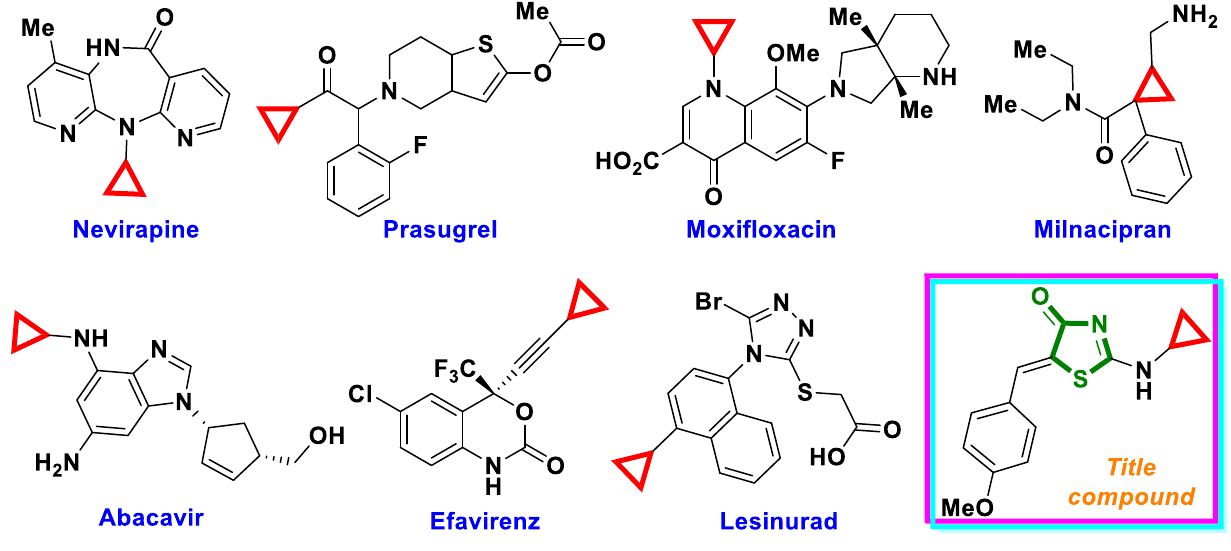
Figure 1. Structures of cyclopropyl-moiety-containing drugs.